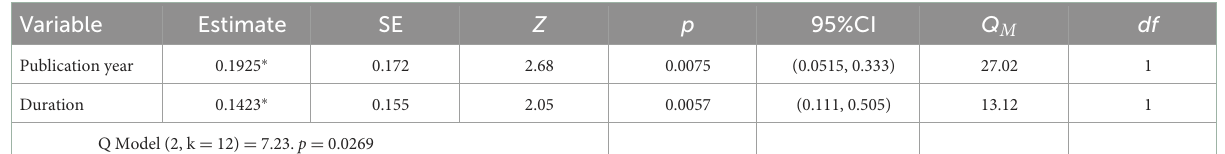
TABLE 4 Meta-regression analysis of continuous variables (random-effects